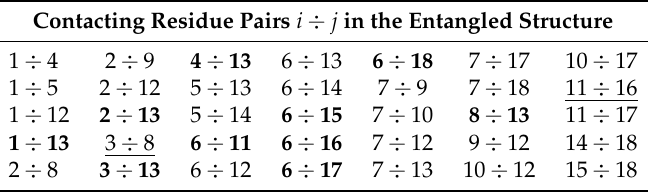
Figure 1. ( a ) Entangled native state. ( b ) Non-entangled native state. The putative “twin” native states are two self-avoiding walks on the fcc lattice with N = 18 sites. The two loops shown in red and blue are concatenated in the entangled structure, and not concatenated in the non-entangled structure. The amino acids at the ends of each loop form the contacts (dashed yellow and green lines) whose energy is studied in this work. Table 1. For the entangled protein structure (Figure 1a), pairs i ÷ j for which ∆ i , j = 1. Underlined pairs refer to the contacts at the ends of loops discussed in this work. Pairs in bold-face (10 over 35) refer to the contacts that are not present in the non-entangled “twin” (Table 2).